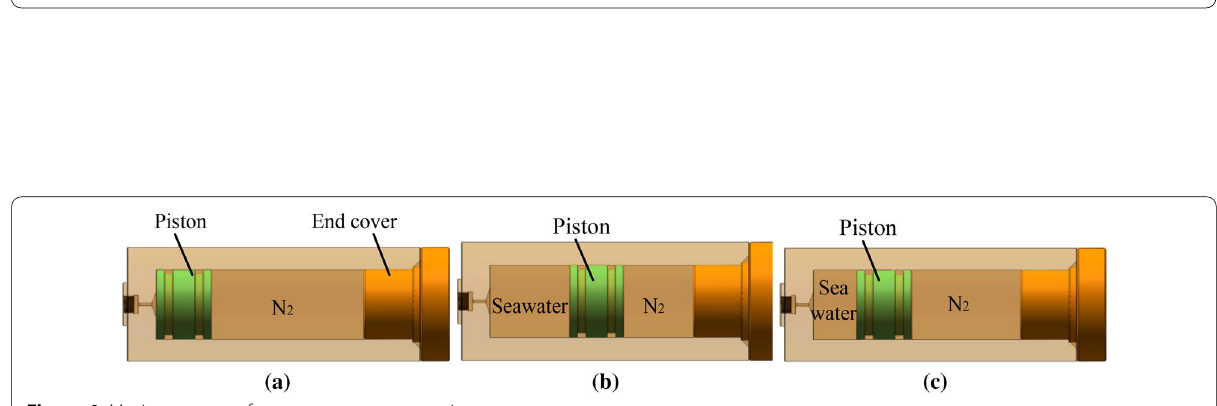
Figure 4 Motion process of pressure compensator